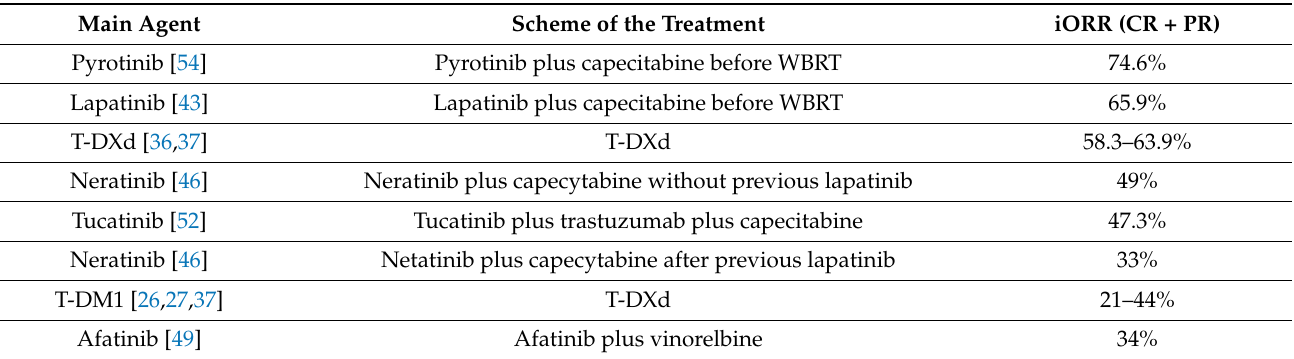
Table 2. The most effective systemic drugs used in breast cancer patients with brain metastases (intracranial objective response rate iORR >